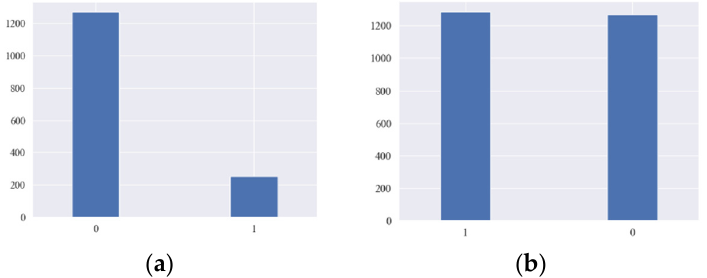
Figure 3. Distribution of normal (0) and abnormal (1) contracts before and after balancing our dataset. ( a ) Original training class labels. ( b ) Oversampled training class labels.